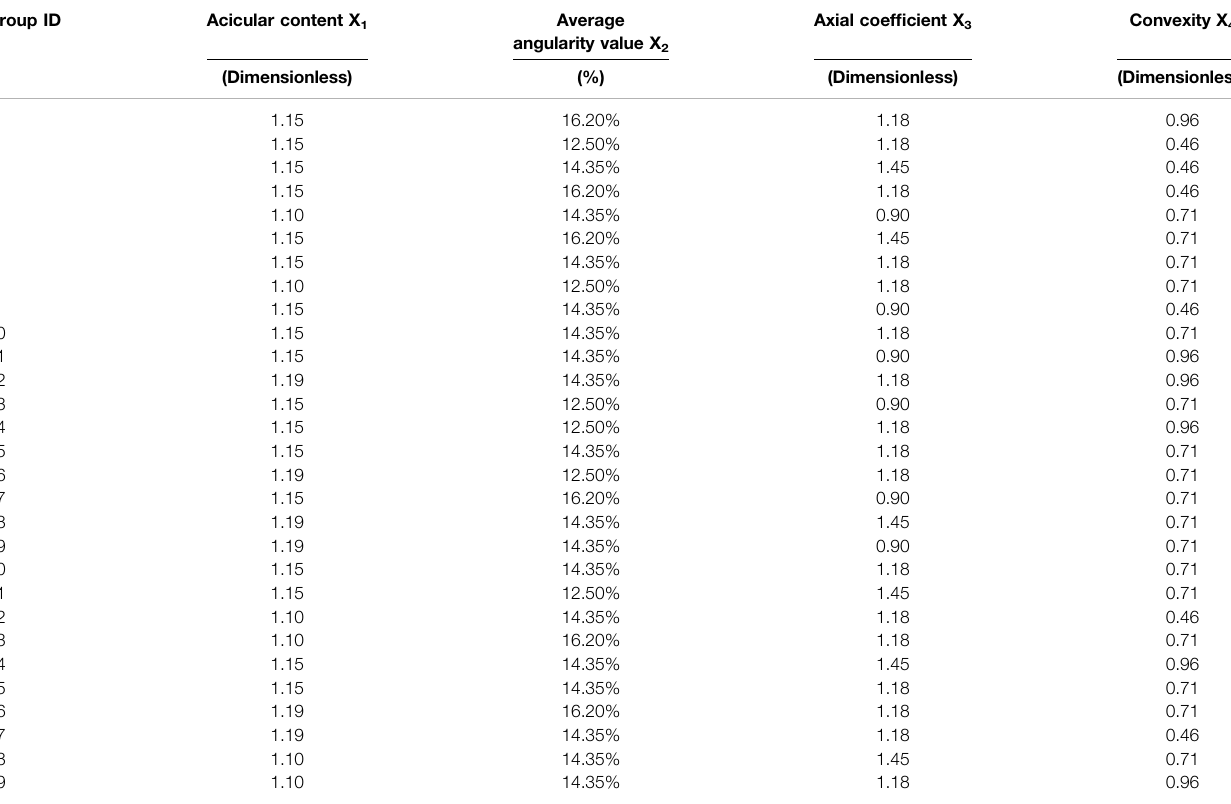
TABLE 3 | Average value of sample aggregate shape data.